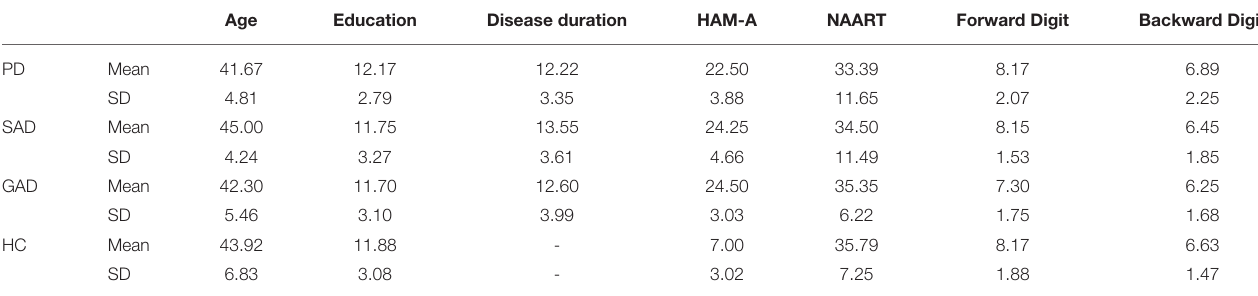
TABLE 1 | Summary of demographic and neuropsychological results. Age Education Disease duration HAM-A NAART Forward Digit Backward